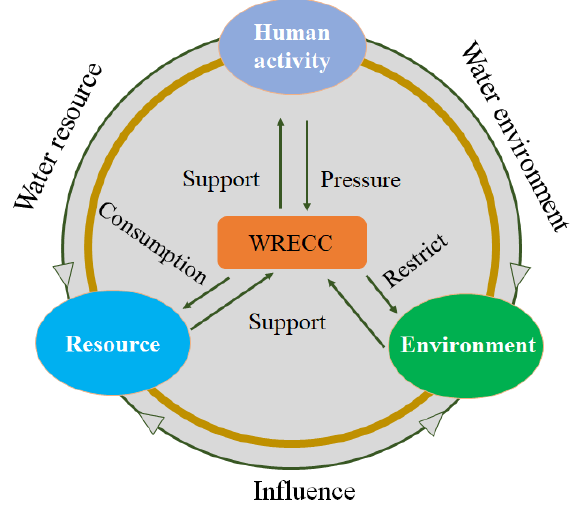
Figure 1. Proposed coupling mechanism between water resource, water environment, and human activities.